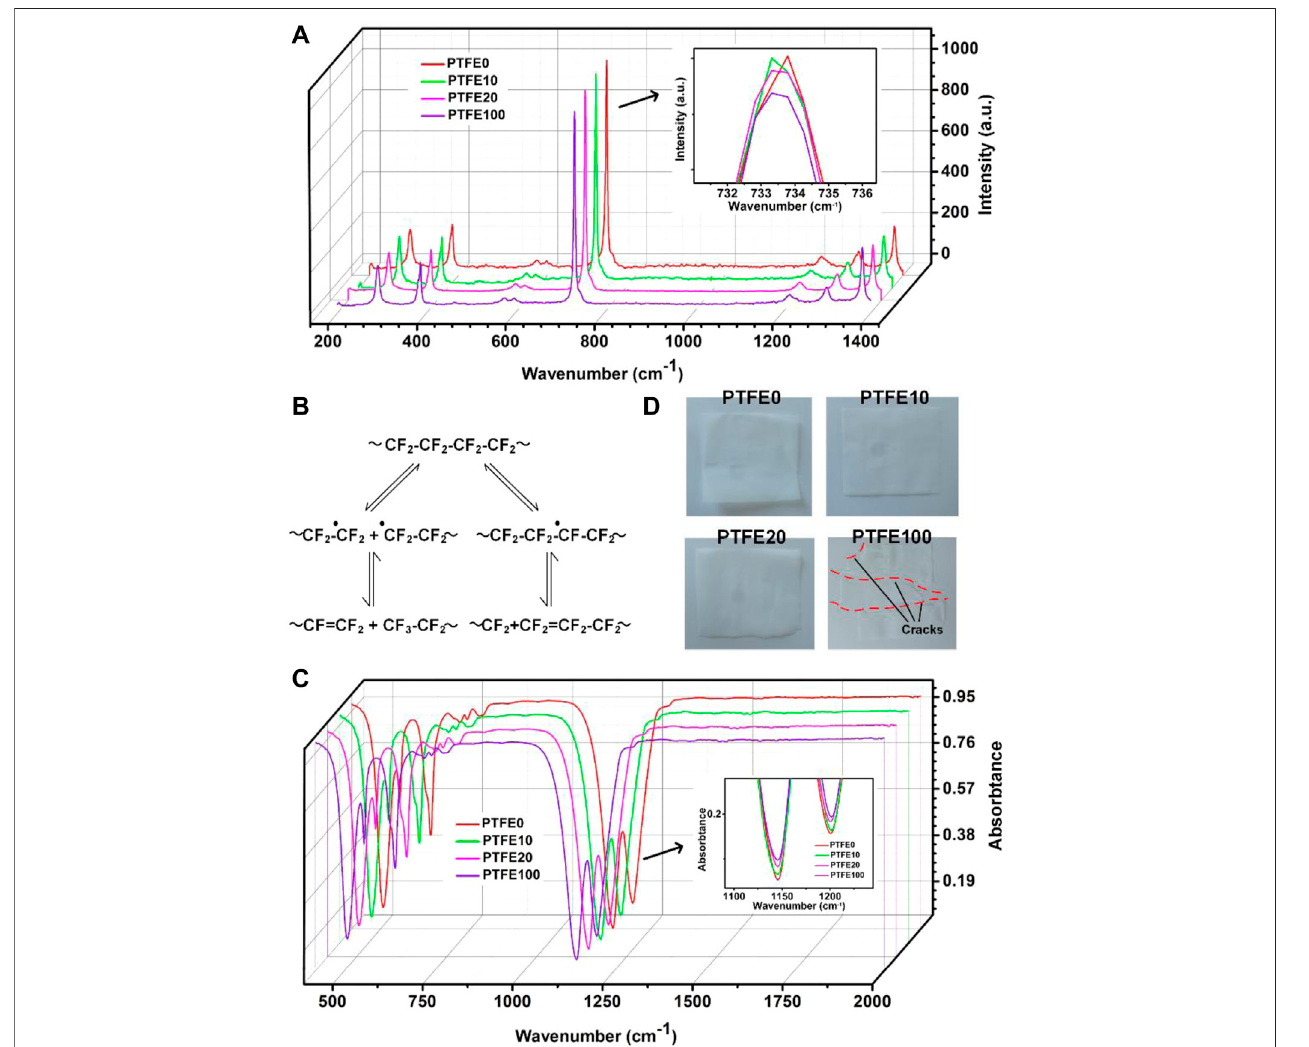
FIGURE 3 | FTIR and Raman analysis ofPTFE samples: (A) Raman test and zoom in CF2 vibration peak, a slight decrease shows that some C-F bond got broken (similar with the result of PVC samples, Supplementary Figure S2 ); (B) possible reactions under gamma radiation; (C) FTIR test and zoom in CF2 vibration peak, corresponding with Raman test; (D) optical images of PTFE samples, showing that PTFE after long-time radiation become crumbly.